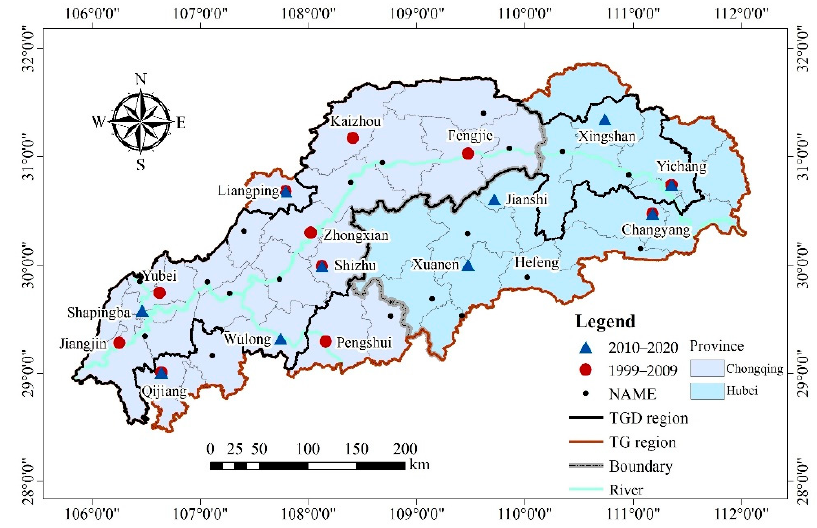
Figure 7. Spatial distribution of maximum 1 h precipitation stations in the TGRR during 1999–2009 and 2010–2020 .